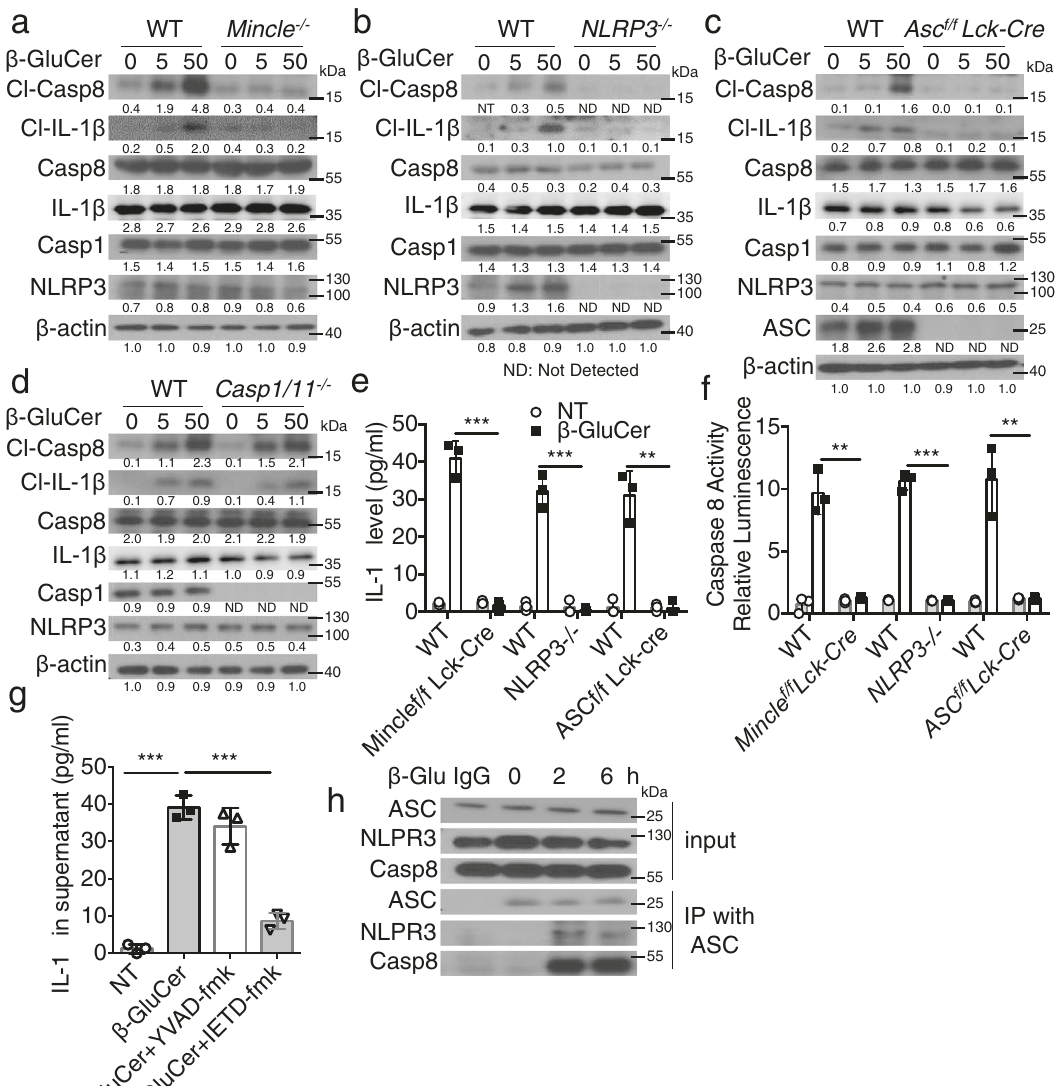
Fig. 5 Mincle activation leads to pro-IL-1 β processing and secretion in T H 17 cells. a – d Polarized T H 17 cells from indicated murine strains were stimulated with β -glucosylceramide (0, 5, 50 μ g/ml) for 12h, followed by western blot analysis of supernatants and cell lysates with the indicated antibodies, density values measured using Image J for the representative blot shown, ND not detected. e Supernatants from a – d were harvested and IL-1 β concentrations were determined by ELISA, n = 3 biological replicates. f T H 17 cells were stimulated with β -glucosylceramide (50 μ g/ml) for 12h, caspase 8 Glo Assay reagent was added to the media for another 1h, followed by analysis by luminescence, n = 3 biological replicates. g IL-1 β concentrations were analyzed from the supernatant of polarized T H 17 cells pretreated with caspase inhibitors (YVAD-fmk/caspase1 inhibitor, IETD-fmk/caspase 8 inhibitor) and stimulated with β -glucosylceramide, n = 3 biological replicates. h Cell lysates from T H 17 treated with β -glucosylceramide (50 μ g/ml) were subjected to immunoprecipitation with anti-ASC, followed by western analysis with the indicated antibodies, data is representative of three independent experiments.* p <0.05, *** p <0.001(two-sided student ’ s t test for e – g ). Data are represented as mean±SD. Exact P values for asterisks (from left to right): e 0.00015 0.00024 0.0015 f 0.0011 0.00002 0.0039 g <0.0001